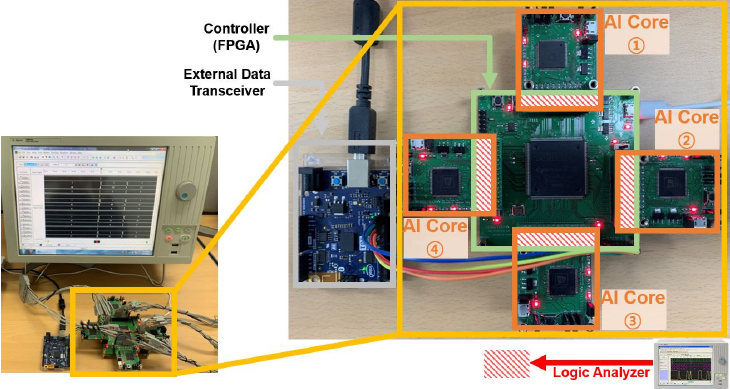
Figure 6. Experimental environment of the FPGA implementation.